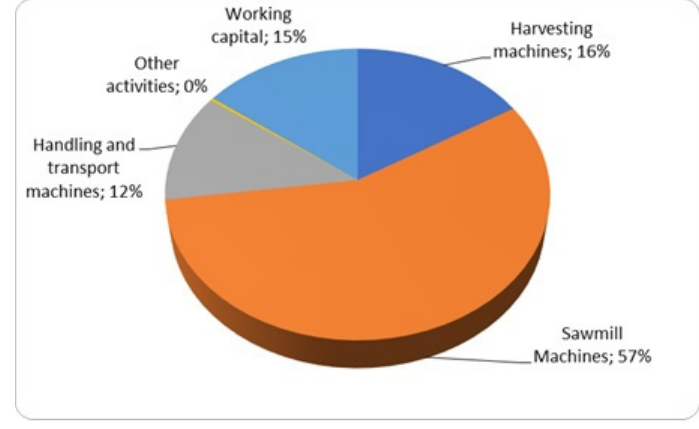
Figure 4. CO 2 emissions by types of actions.